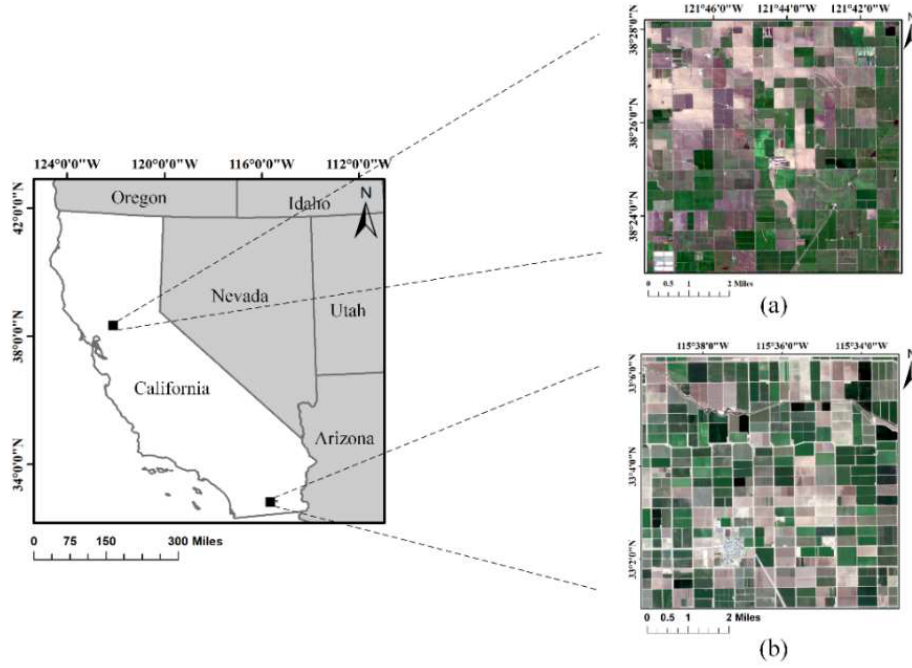
Figure 1. The study areas in California. The crop areas of interest (AOI) in study area 1 and 2 with true color composite of Sentinel-2. ( a ) study area 2 dated on 2019/02/10 ( b ) study area 1 on 2018/03/12 .